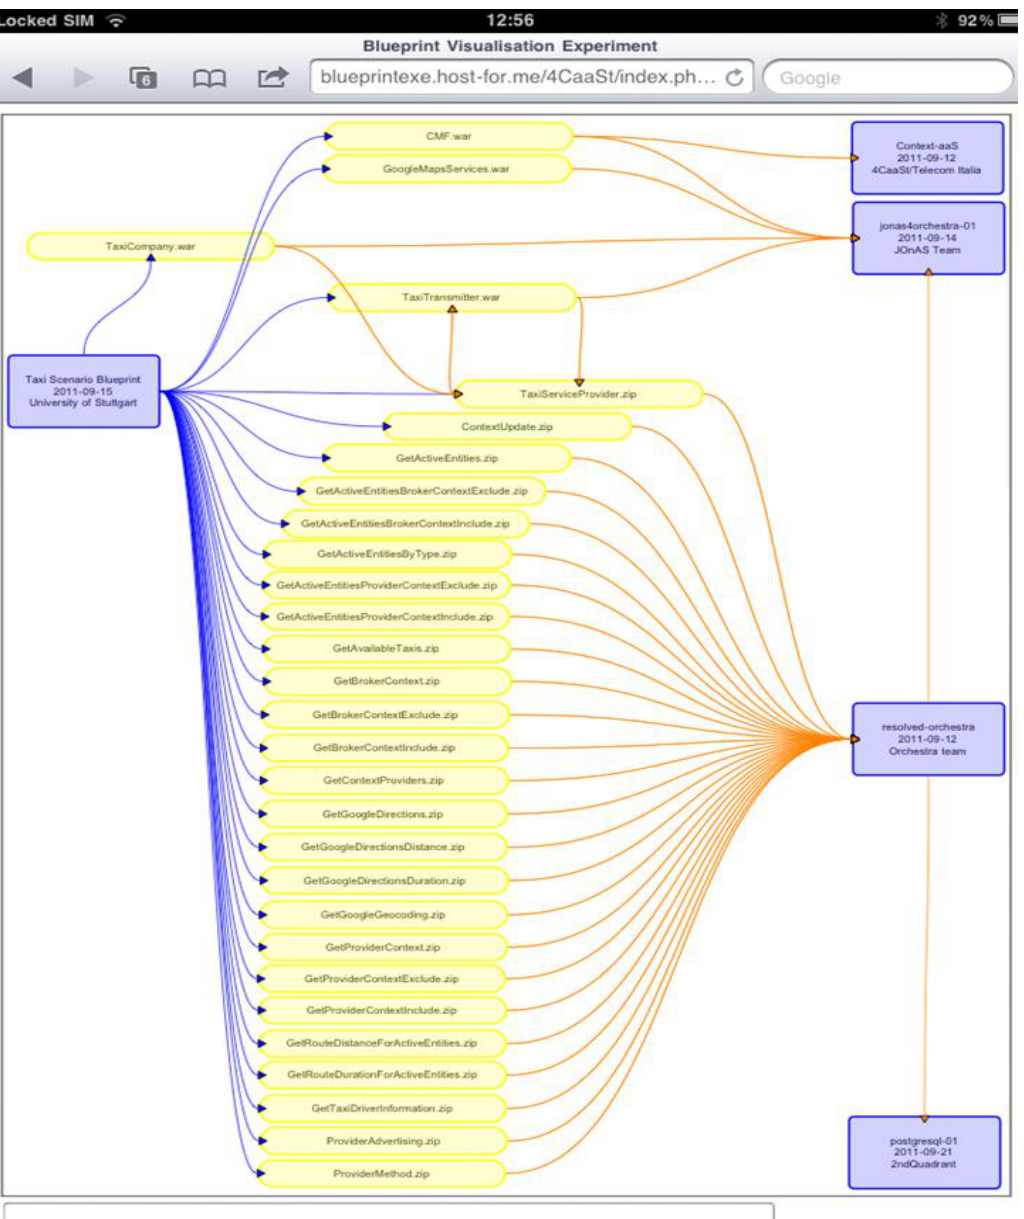
Figure 12. The web interface of our blueprint prototype showing a resolved